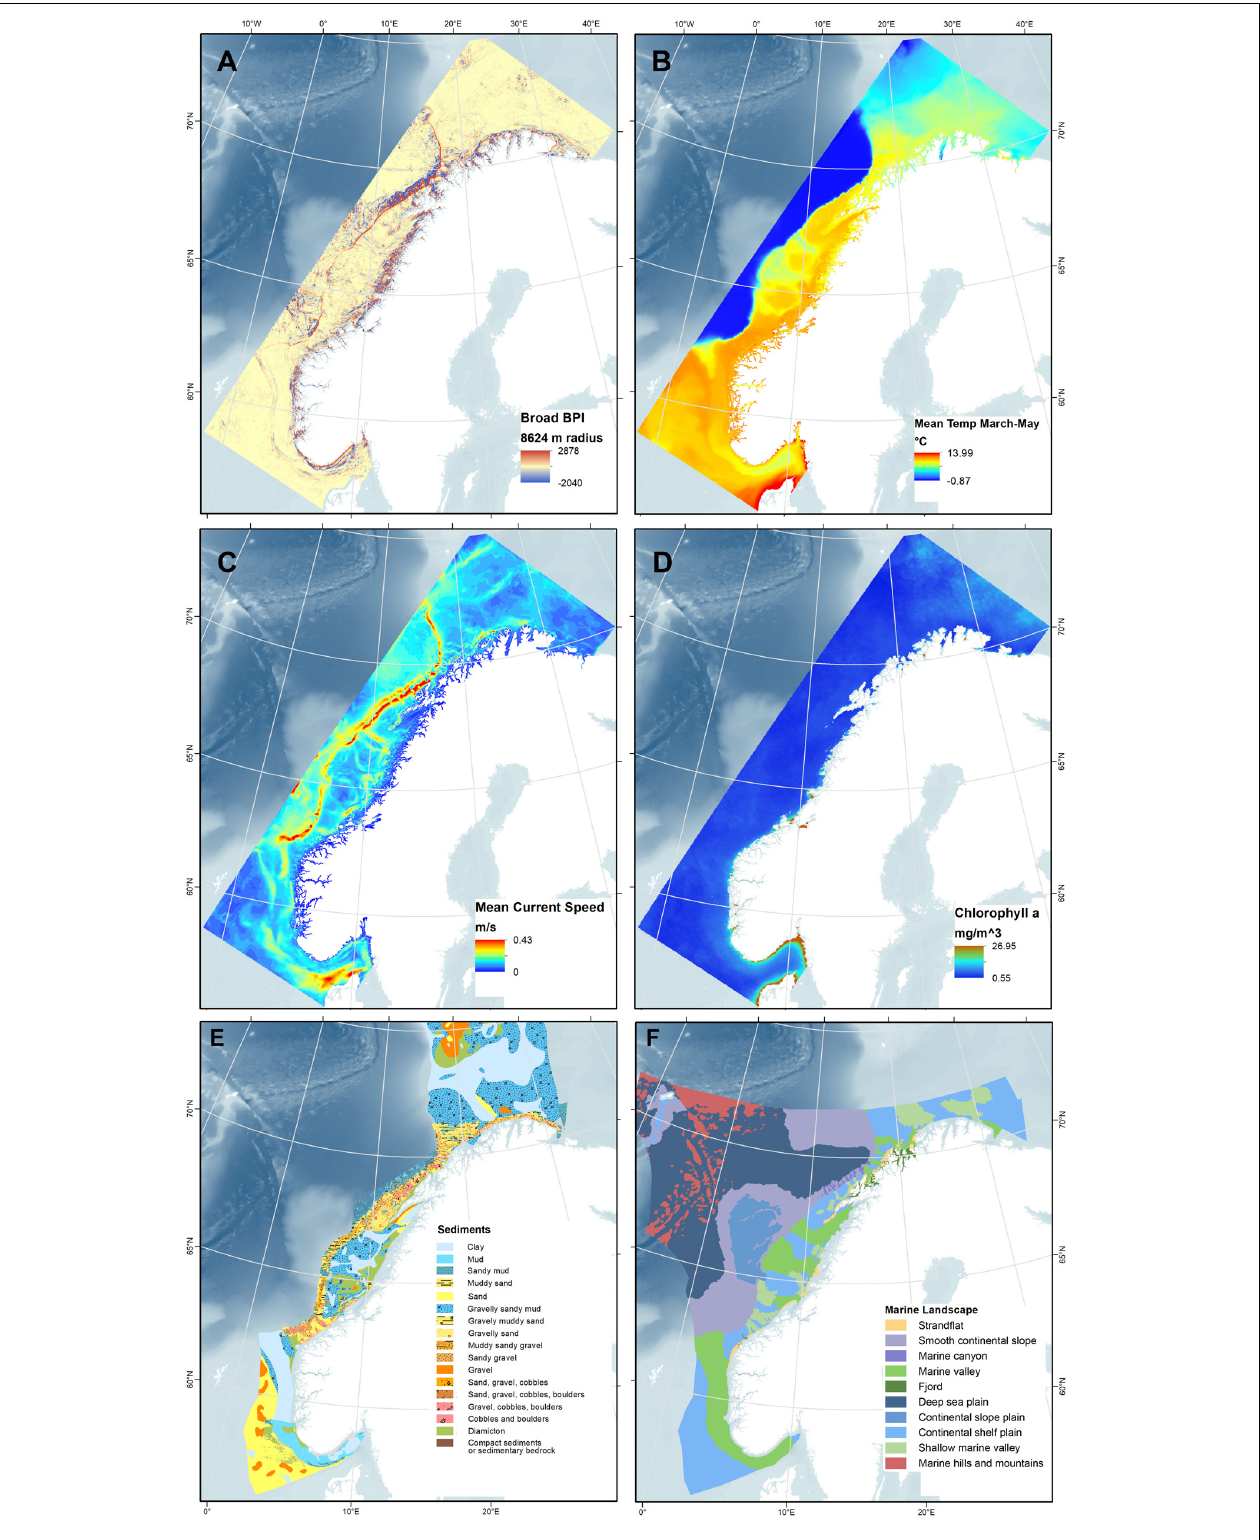
FIGURE 2 | Maps of four selected numerical environmental variables (A–D) , and two categorical variables (E,F) . (A) Broad BPI, (B) minimum temperature (mean March through May), (C) mean current speed, (D) chlorophyll a concentration, (E) sediment type (classified by grain size, based on and modified from Folk (1954) combining MAREANO’s finer Regional map and the coarser Continental Shelf map from the National Atlas for Norway, 1991), and (F) Marine landscape types classified by MAREANO.